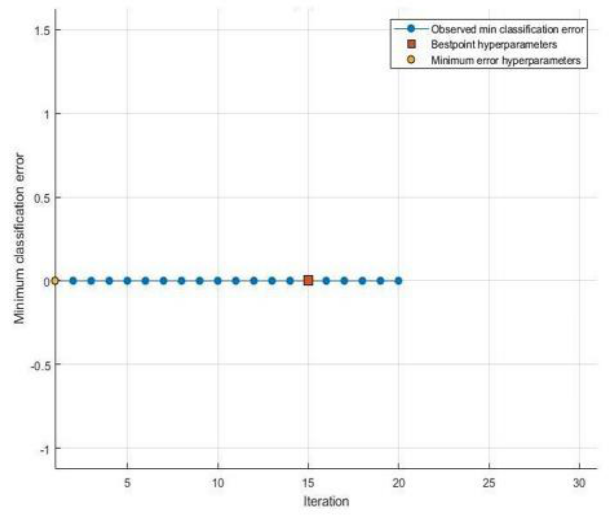
Fig. 27. Video injection minimum classification error of bayesian based optimized tree